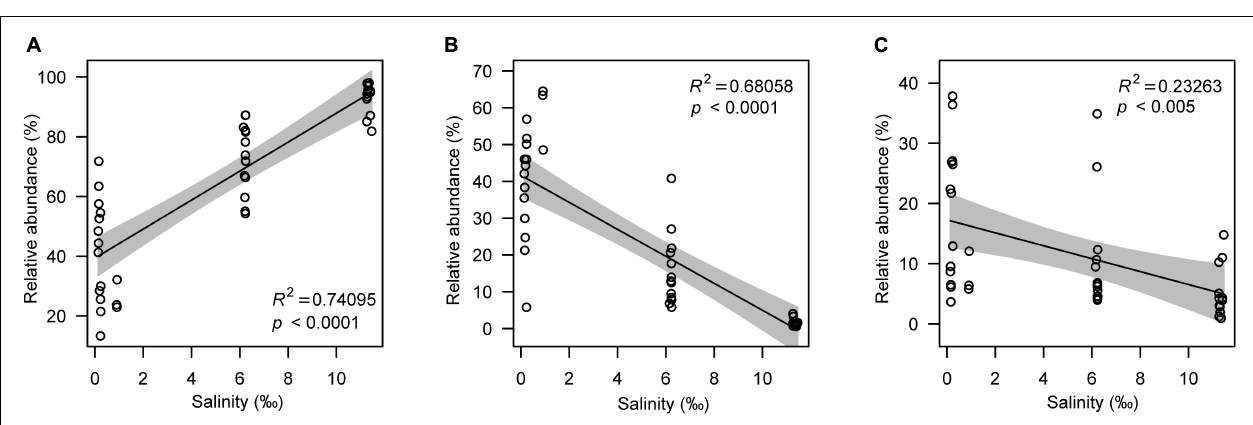
FIGURE 4 | The relative abundance of the main microeukaryotic taxa. (A–C) represent algae, protozoa and